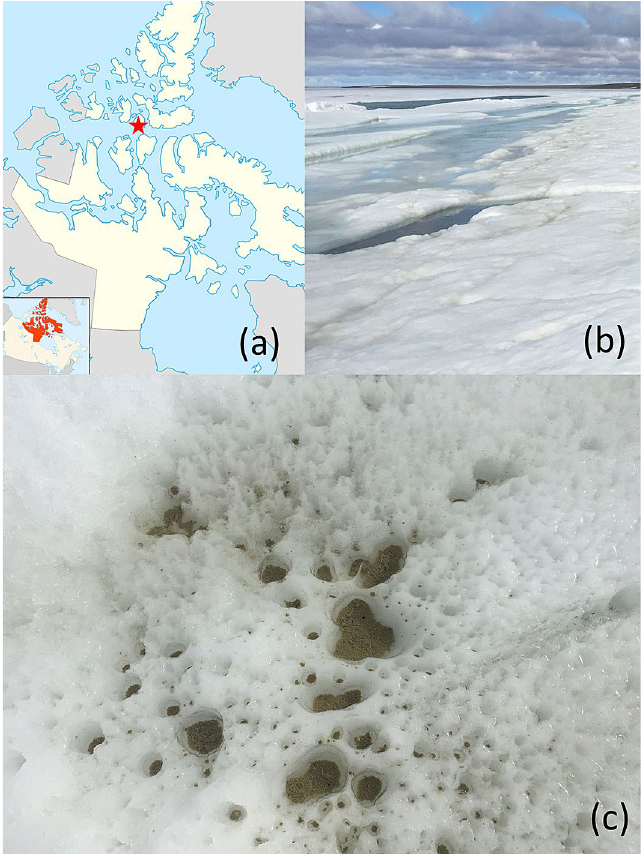
Figure 1. Allen Bay sea ice location and cryoconites. ( a ) Sampling location in the Canadian high Arctic (latitude: 74.44707; longitude: − 95.0348). Map generated by Google maps version 10.86.1 (https:// www. google. com/ maps/ place/ Resol ute,+ NU/@ 76. 31824 14,- 114. 86981 66,4z/ data= !4m5!3m4!1s0x5 1dc1a f3fbf 4579b: 0x986 b5292 16b12 3b6!8m2!3d74. 69729 9!4d- 94. 82972 89). ( b ) Ground view of the Allen Bay sea ice. Photo taken on